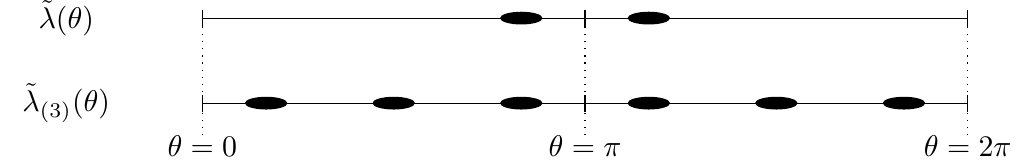
3 -symmetric source is non-zero in the (3)